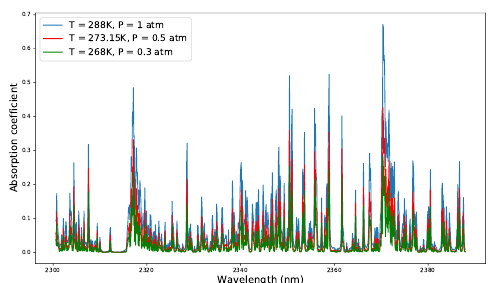
Figure 2. Comparison of methane absorption spectra under several pressure/temperature conditions.